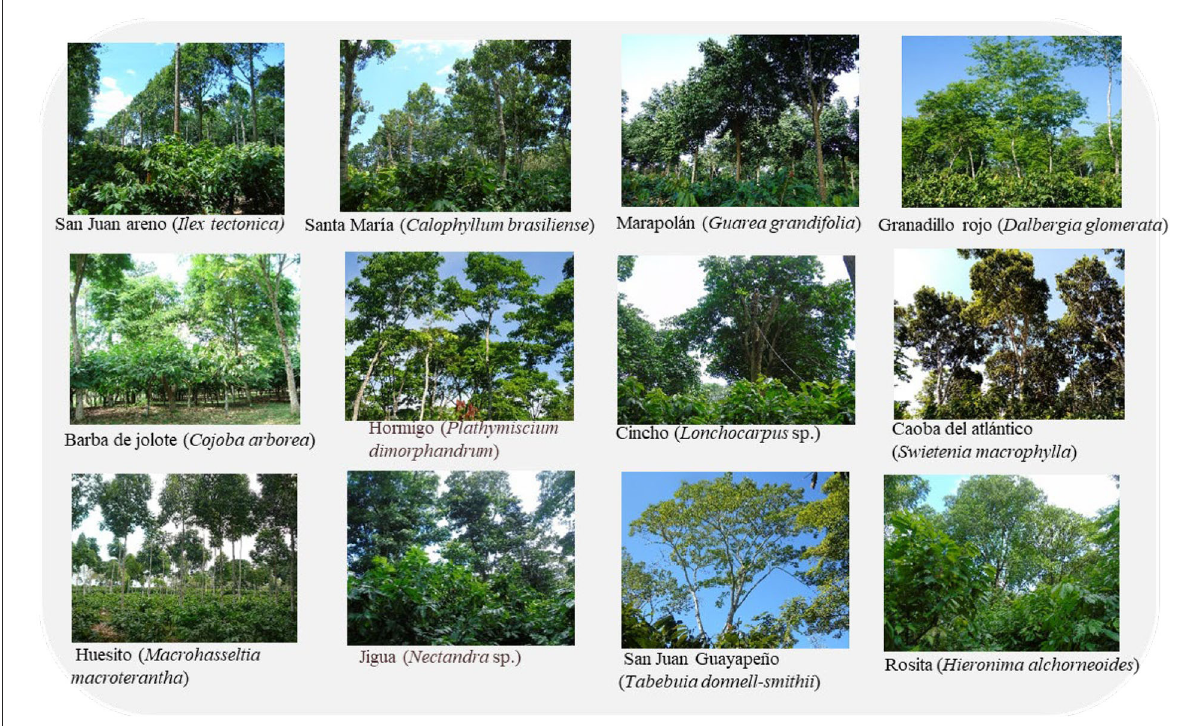
FIGURE1 Top 12 timber shade species intercropped with cacao and assessed in the experimental site “CEDEC-JAS”, La Masica, Atlántida,